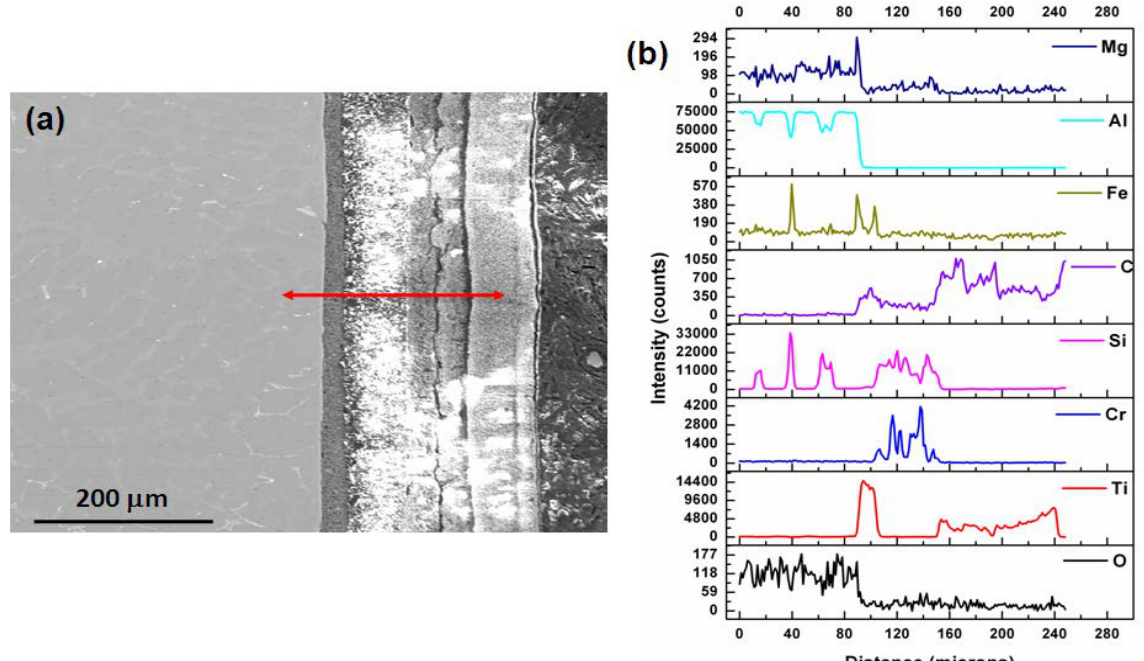
Figure 17: (a) BSE EPMA image taken from the edge consisting of three layers of paint. The region of line scan on paint is shown by double arrow (in red colour) and (b) EPMA elemental line scans taken from the double arrow shown in red colour in Fig.